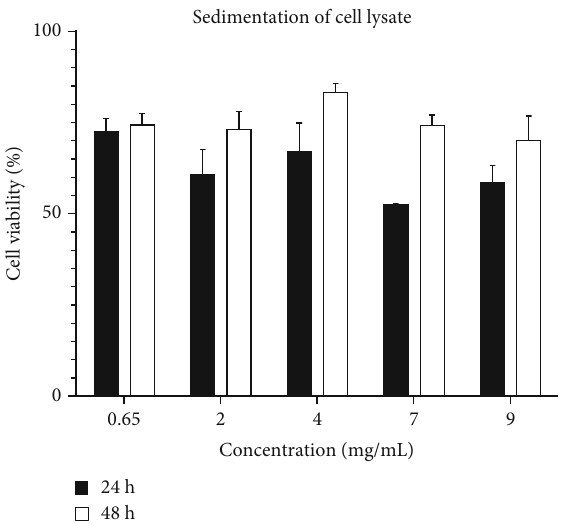
Figure 3: E ff ect of ke fi r drink supernatant (yielded after 48 hours fermentation) on U87 cell viability after 24 and 48 hours ( P value ≤ 0.5).